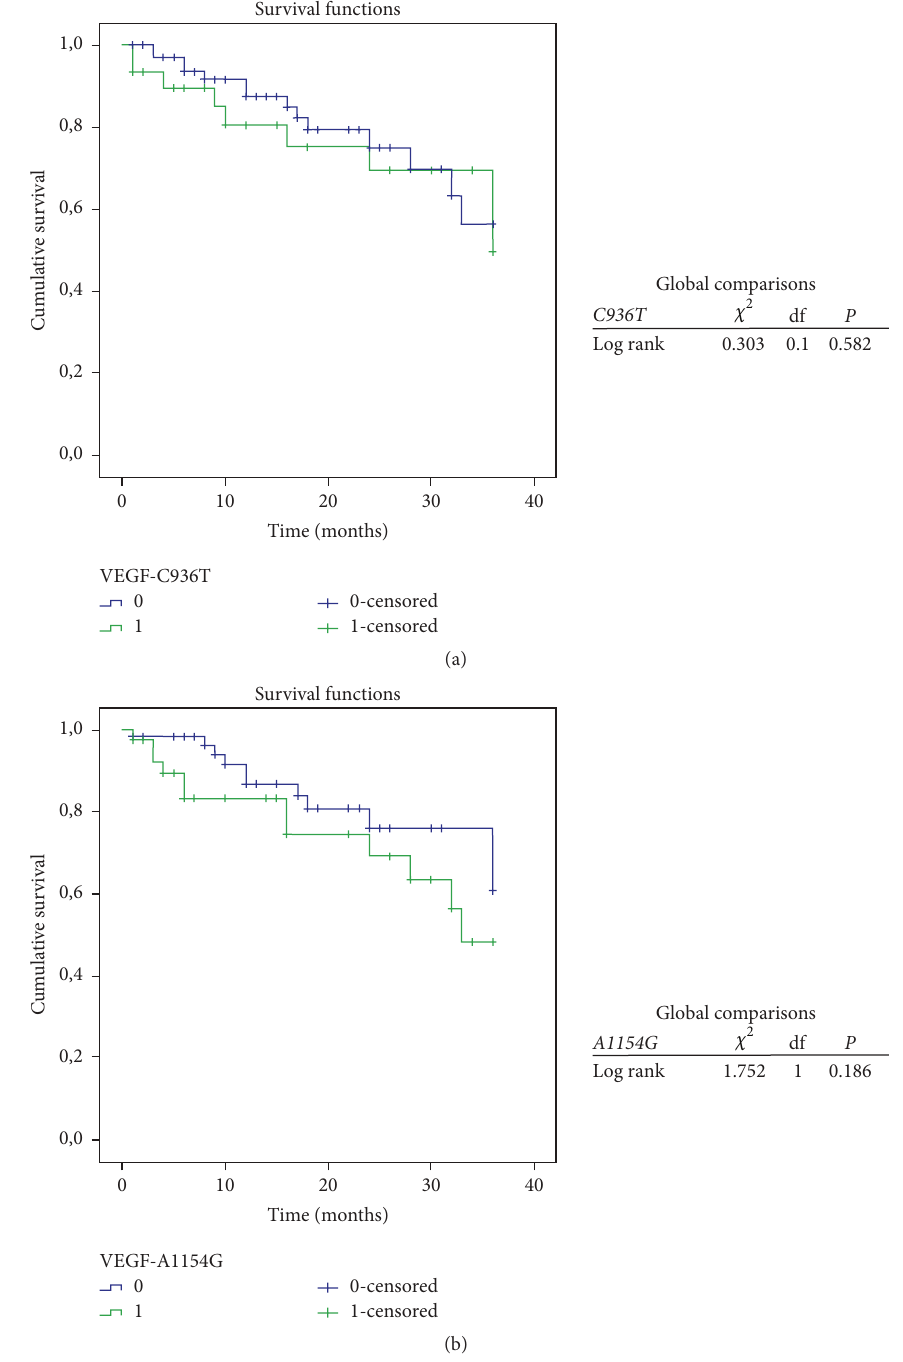
Figure 1: Kaplan-Meier curve for overall survival analysis of patients with hepatocellular carcinoma after 36 months of diagnosis. (a) VEGF - C936T: 1 = genotype C/T, 0 = genotype C/C; (b) VEGF -A1154G: 1 = genotypes /A, 0 = genotype G/G; df = degree of